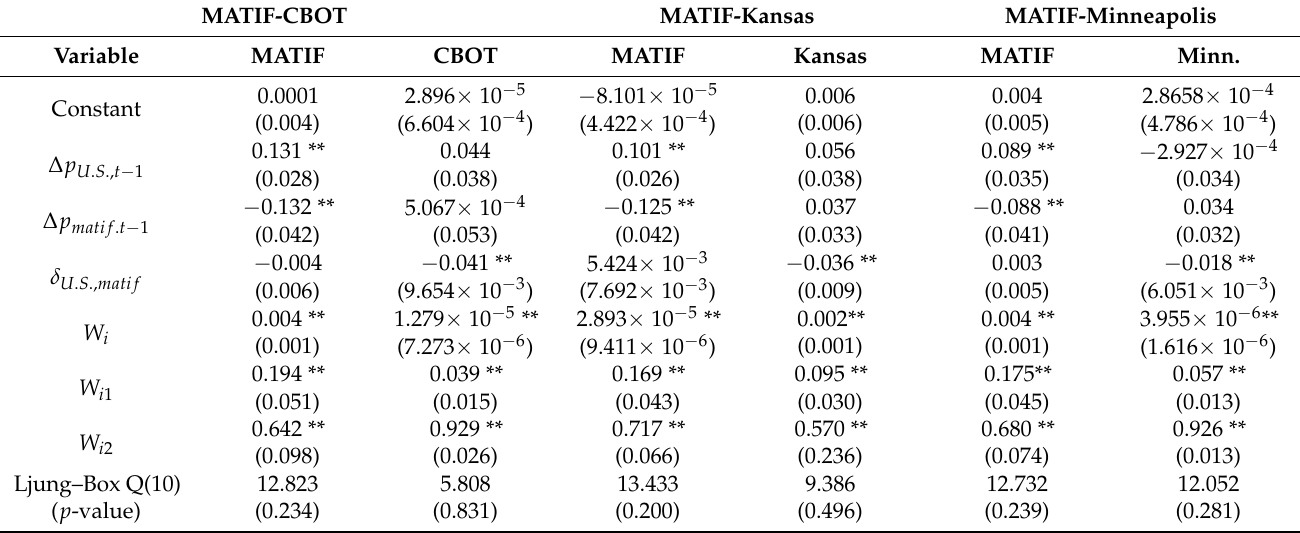
Table 7. Results for the univariate ECM-GARCH (1,1) model for the third period.